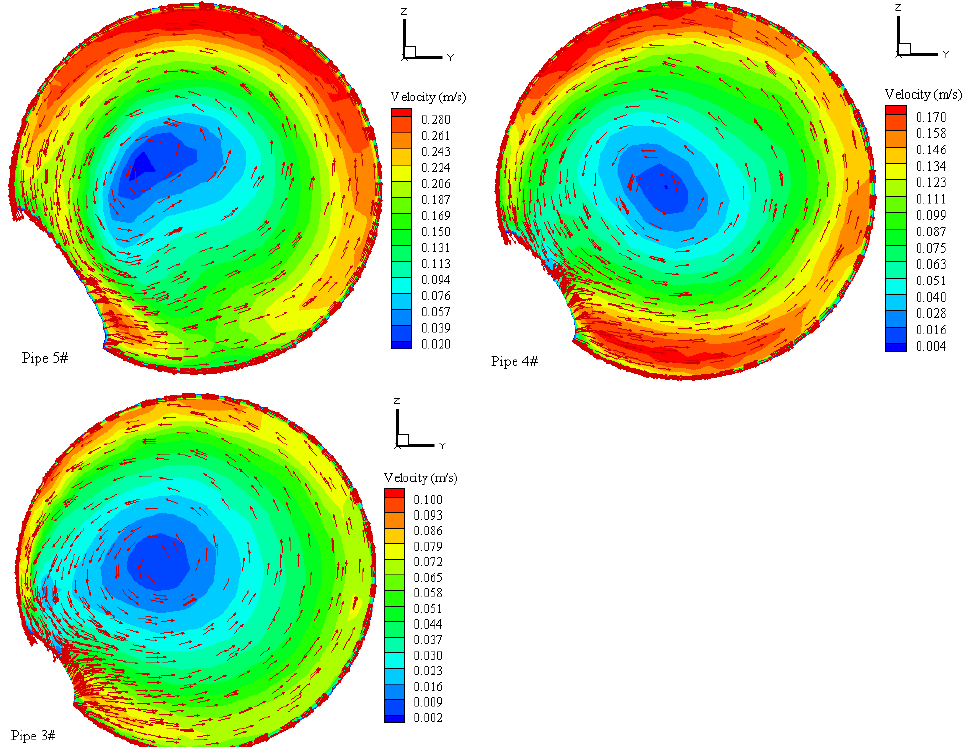
Figure 6. Secondary flow and vector distribution on the cross section of SCPs.